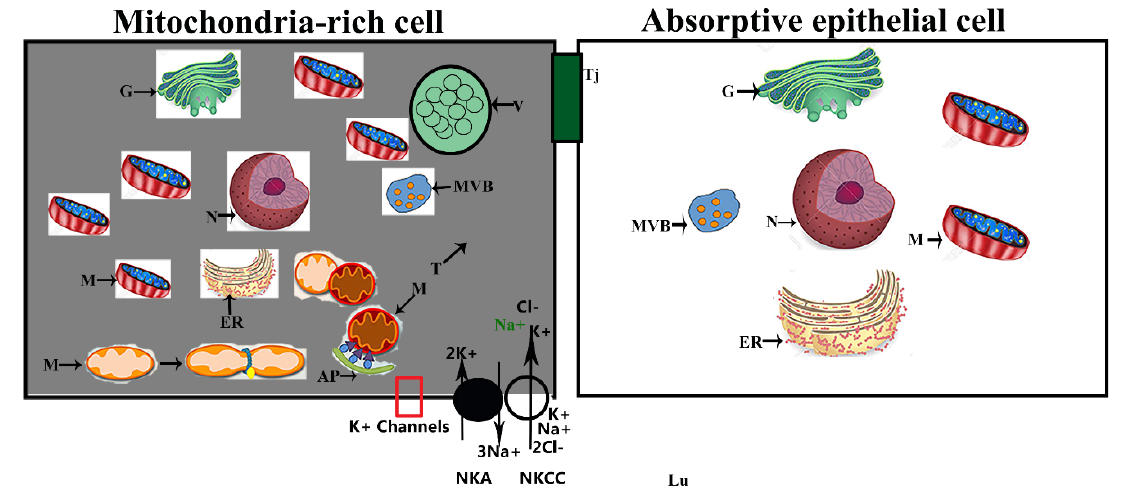
Figure 7. Schematic diagram of morphology and functional activity of MRC in the small intestine of P. sinensis . Dense cytoplasm MRCs contain greater numbers of mitochondria and a tubular system compared to absorptive epithelial cells. Cl − enters MRCs via a Na + / K + / 2Cl – cotransporter (NKCC) driven by the Na + gradient, which is maintained by Na + / K + − ATPase (NKA). The red rectangle highlights the potassium channels required in this process. Nucleus (N), mitochondria (M), endoplasmic reticulum (ER), autophagosome (AP), tubular system (T), multivesicular bodies (MVB), vacuolization (V), tight junction (Tj), and Golgi complex (G).